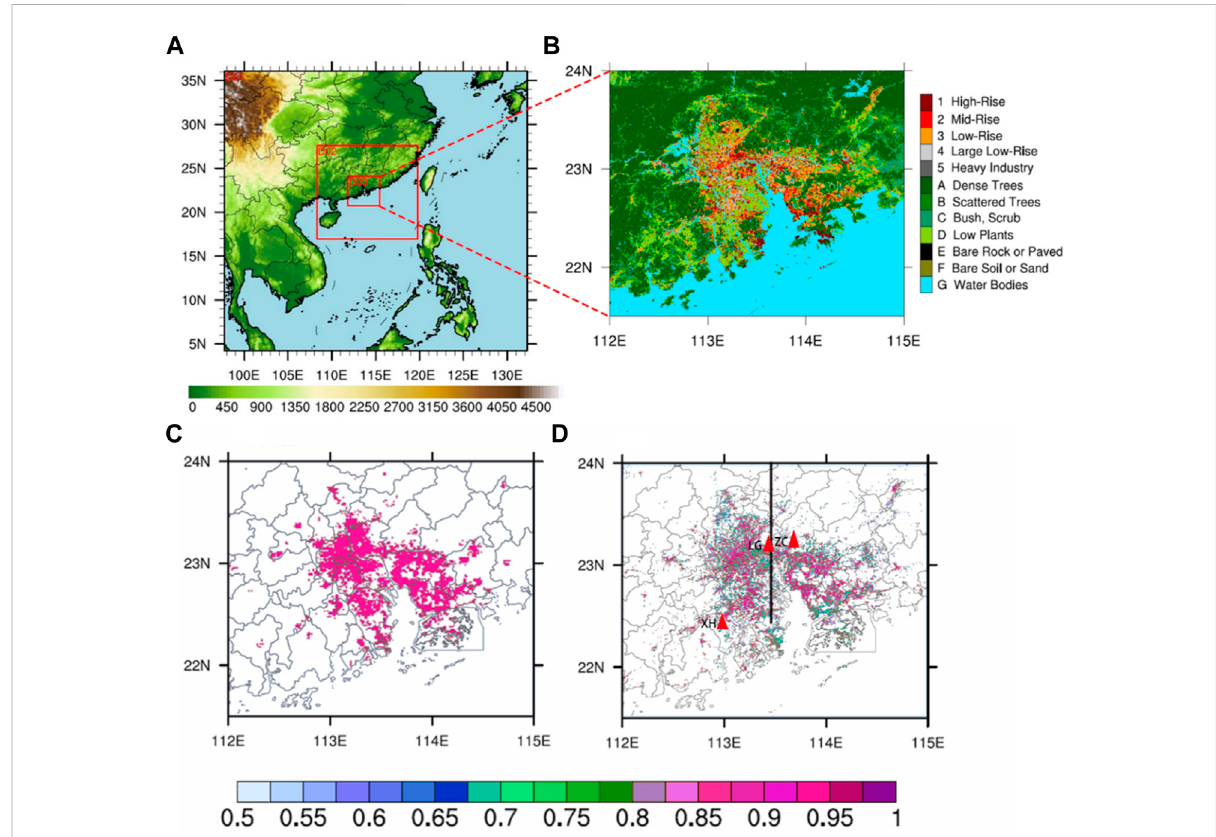
FIGURE 1 (A) Spatial distribution (red frame) and terrain height distribution (shaded; unit: m) of the WRF mesoscale numerical model. (B) Spatial distribution of localized urban land types in the third, fi nest-scale grid area, along with other land types. (C) Proportion of built-up area in the default urban canopy. (D) Proportion ofbuilt-up areainthelocalized urban canopy.The blackline in (D) isthelocationof thevertical cross sectionshown in Figures 10, 11. The red triangles indicate the locations of three wind pro fi ler radar (LG: Luogang, ZC: Zengcheng, XH: